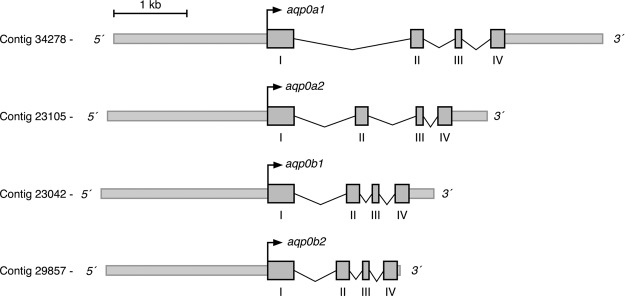
Genomic organization of Atlantic salmon aqp0 genes. Schematic representation of aqp0a1, -0a2, -0b1, and -0b2 gene loci. Gray boxes indicate exons with coding regions only.